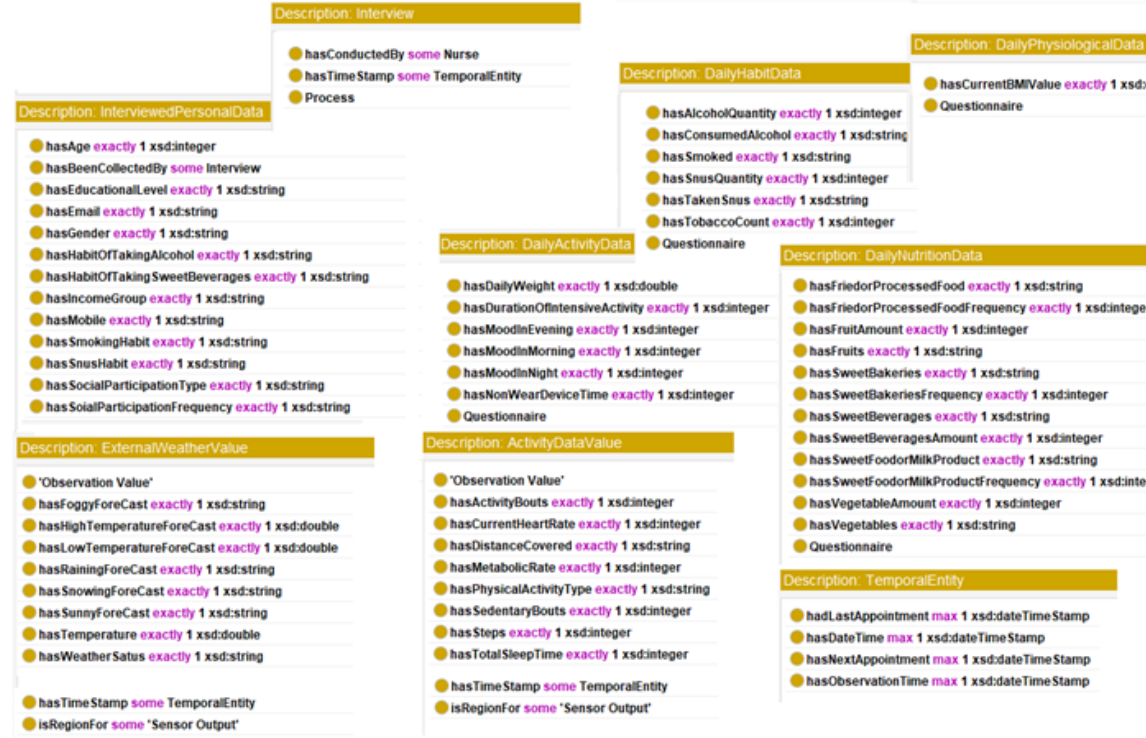
Figure 13. Data properties related to data